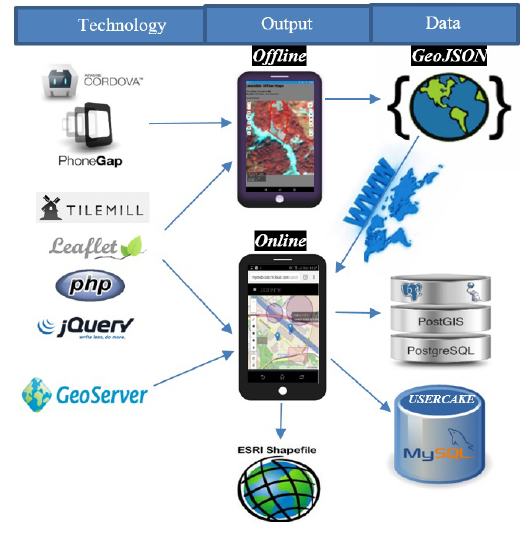
Figure 5. Technology (Cordova and PhoneGap) used by ROOMA, upon which the offline version is built. The online version is based on three-tier architecture which includes the presentation, applica- tion, and data layers. The presentation layer is based on Leaflet, jQuery, and JavaScript. Application layer uses PHP to connect to GeoServer and database. The data layer is composed of both MySQL (UserCake) and PostgreSQL